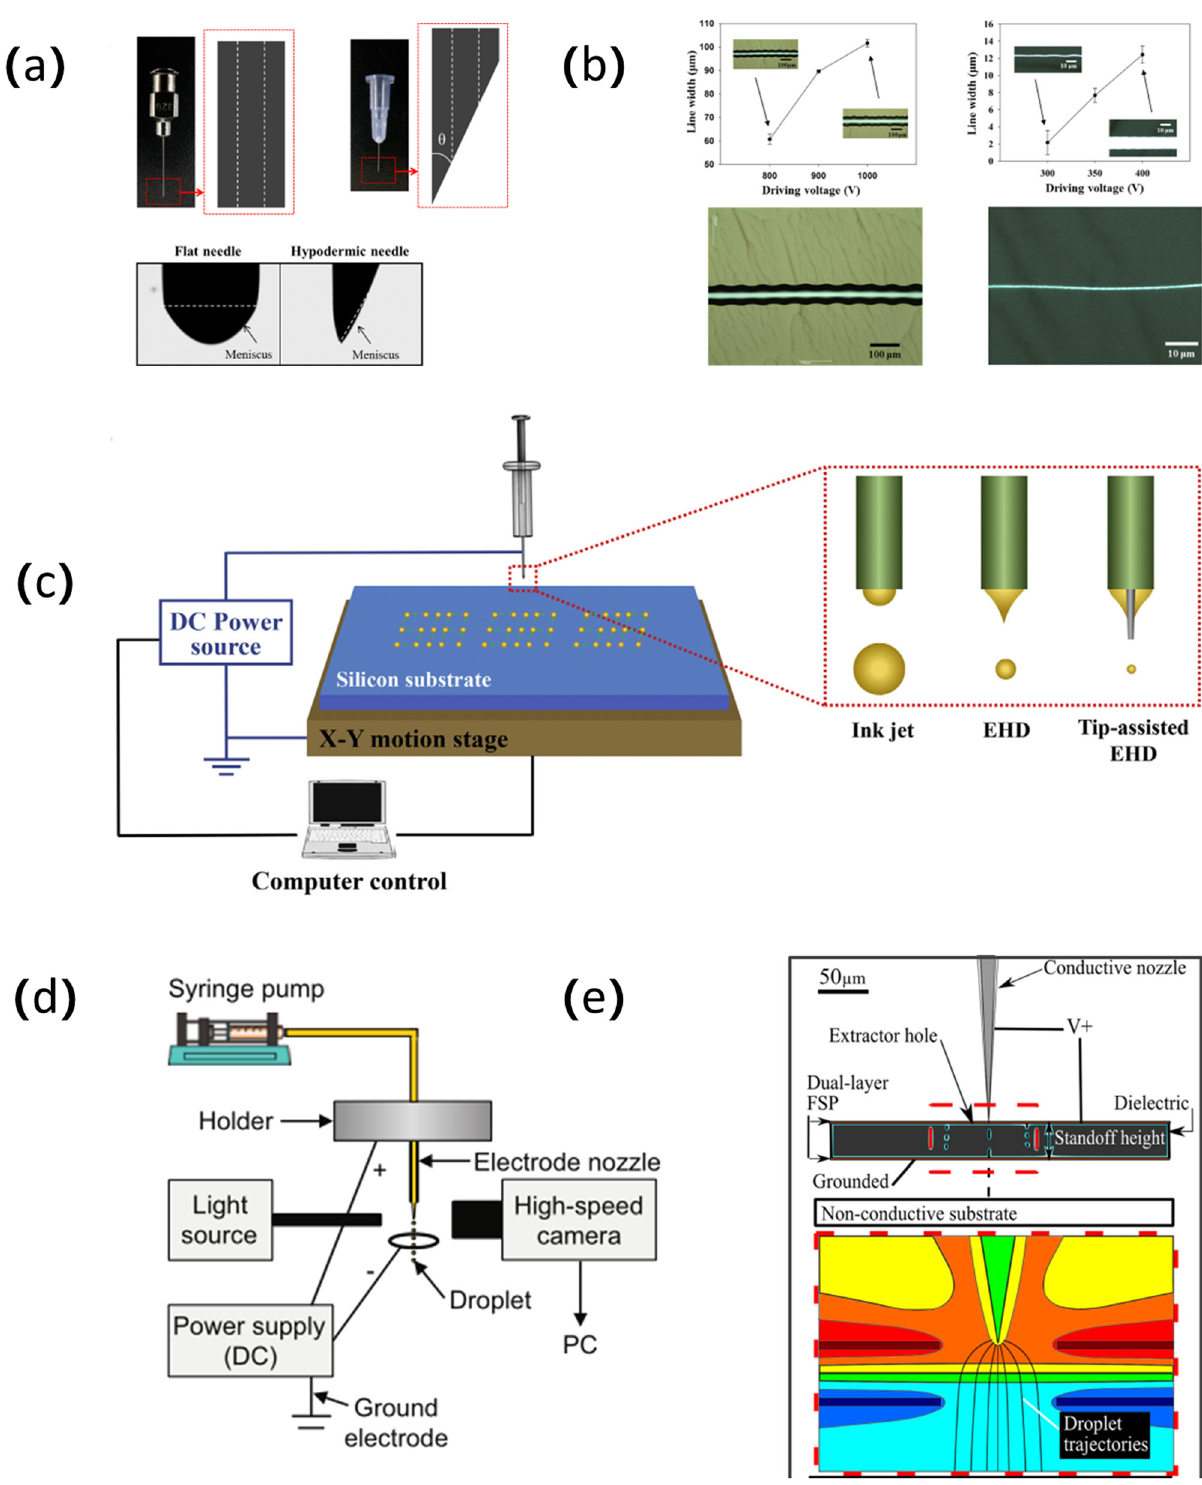
Figure 7: ( a ) Schematic diagram of the fl at exit needle and hypodermic needle. ( b ) From left to right, the line width and shape changes of fl at needles and hypodermic needles with increasing voltage. Reproduced from ref. [ 98 ] with permission from American Institute of Physics. ( c ) Tip - assisted E - jet printing system. Inkjet printing, E - jet printing, and tip - assisted E - jet printing nozzle tip jet comparison chart. Reproduced from ref. [ 100 ] with permission from Elsevier BV. ( d ) Schematic diagram of a printing device with metal ring electrodes. Reproduced from ref. [ 104 ] with permission from Elsevier. ( e ) Double conductive layer electric fi eld forming print head and electric fi eld line distribution. Reproduced from ref. [ 105 ] with permission from American Institute of